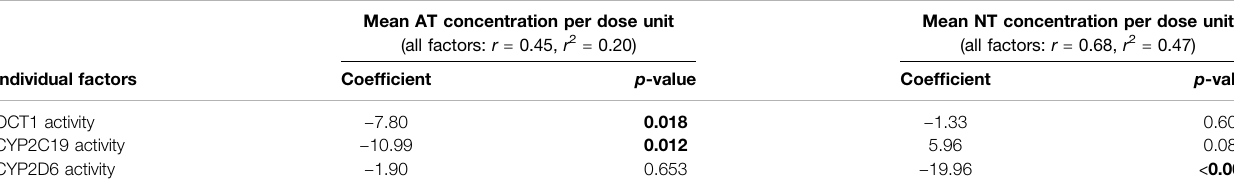
TABLE 7 | Multiple linear regression analysis to determine the individual factors that in fl uence mean plasma AT and NT concentrations per dose unit in depressive disorder patients. Mean AT concentration per dose unit (all factors: r (cid:1) 0.45, r 2 (cid:1)